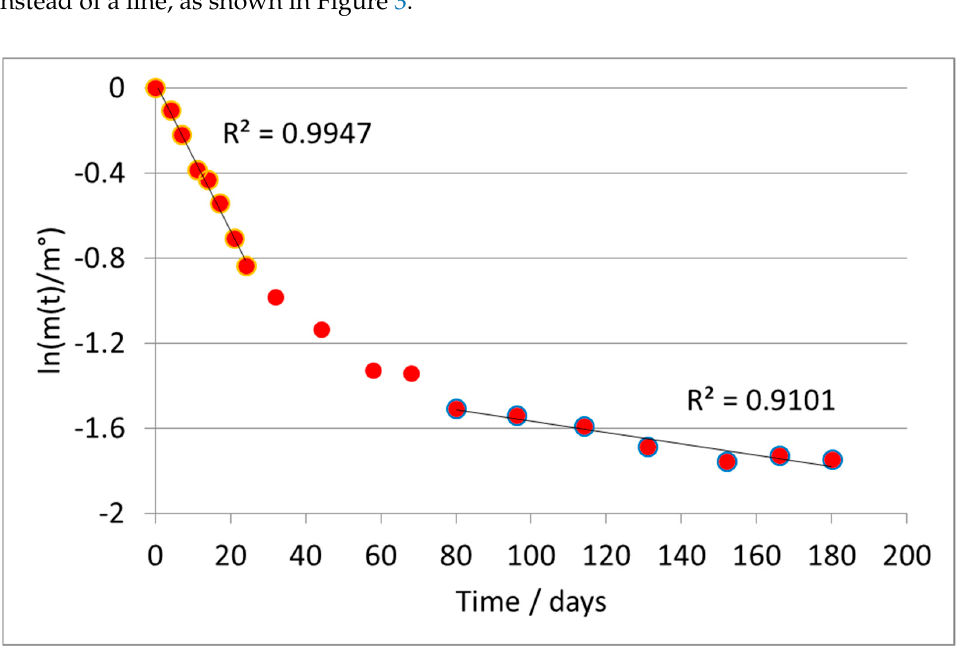
Figure 3. Elaboration of the data of three samples of formulate B according to the first-order model.